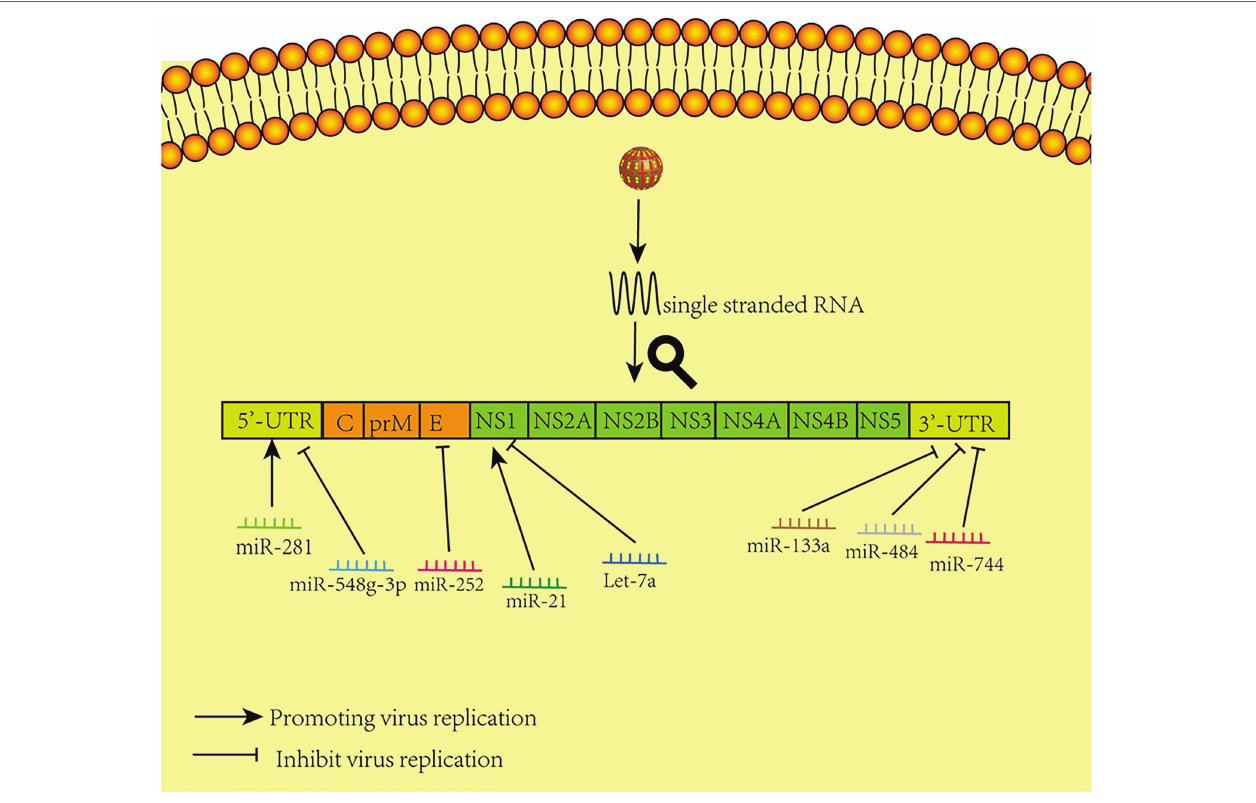
FIGURE 1 | Model of miRNAs that directly target viral genomes. The figure shows that different microRNAs promote and inhibit virus replication by acting directly on corresponding sites in the virus